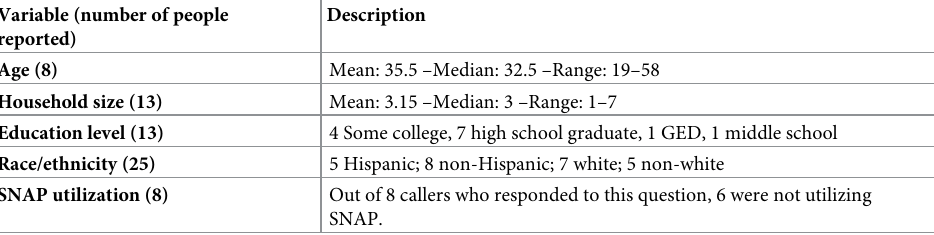
Table 2. Descriptive statistics of 25 selected food-related telephone calls to Utah’s